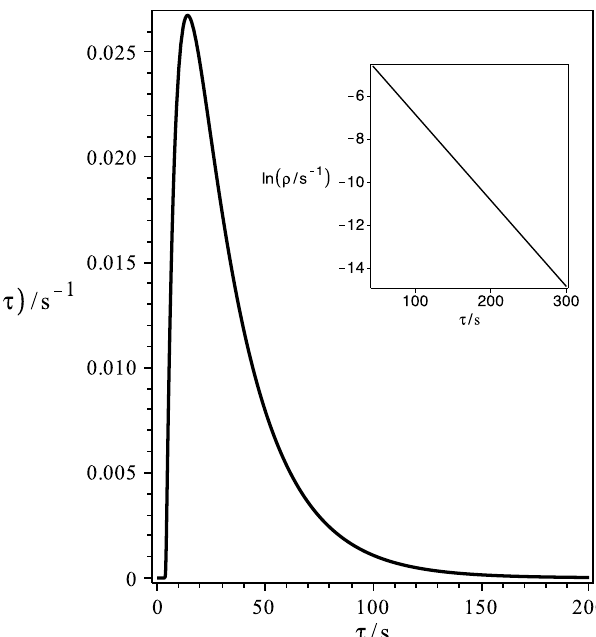
Fig. 3. Distribution of transcription times obtained by semi- numerical Laplace inversion of equation (27) for k 0 = 0 . 04 s − 1 , k 1 = 8 . 0 s − 1 , k 2 = k 3 = 100 . 0 s − 1 , k 4 = 0 . 2 s − 1 and n = 200 nt . The inverse Laplace transform was computed in Maple [41], and stability of the result with respect to the number of floating-point digits used was verified. The inset shows a semi-log plot of the tail (the upper quartile of the